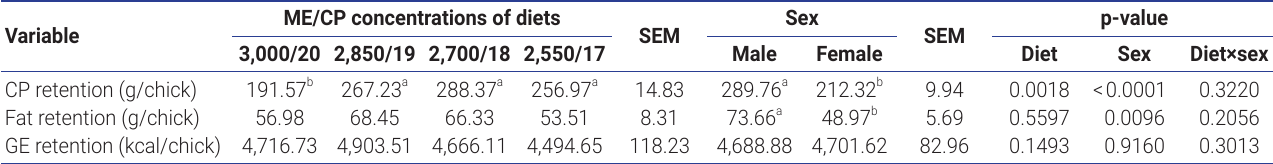
Table 6. Nutrient retention in the whole body of 12-week old of Mexican Creole chickens fed diets with different concentrations of ME and